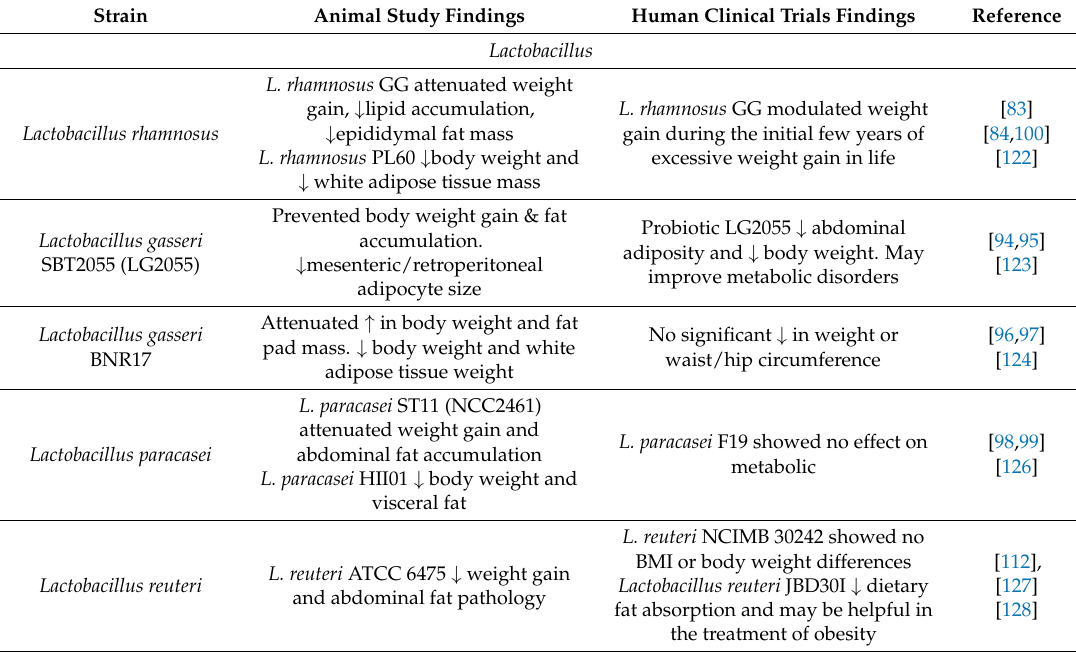
Table 1. Probiotics’ efficacy in animals vs. human clinical